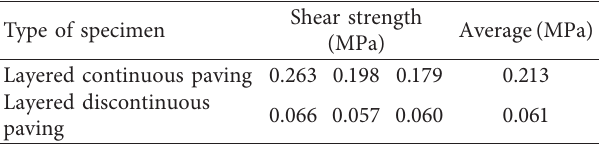
Table 4: Results of double-sided shear test between layers. Type of